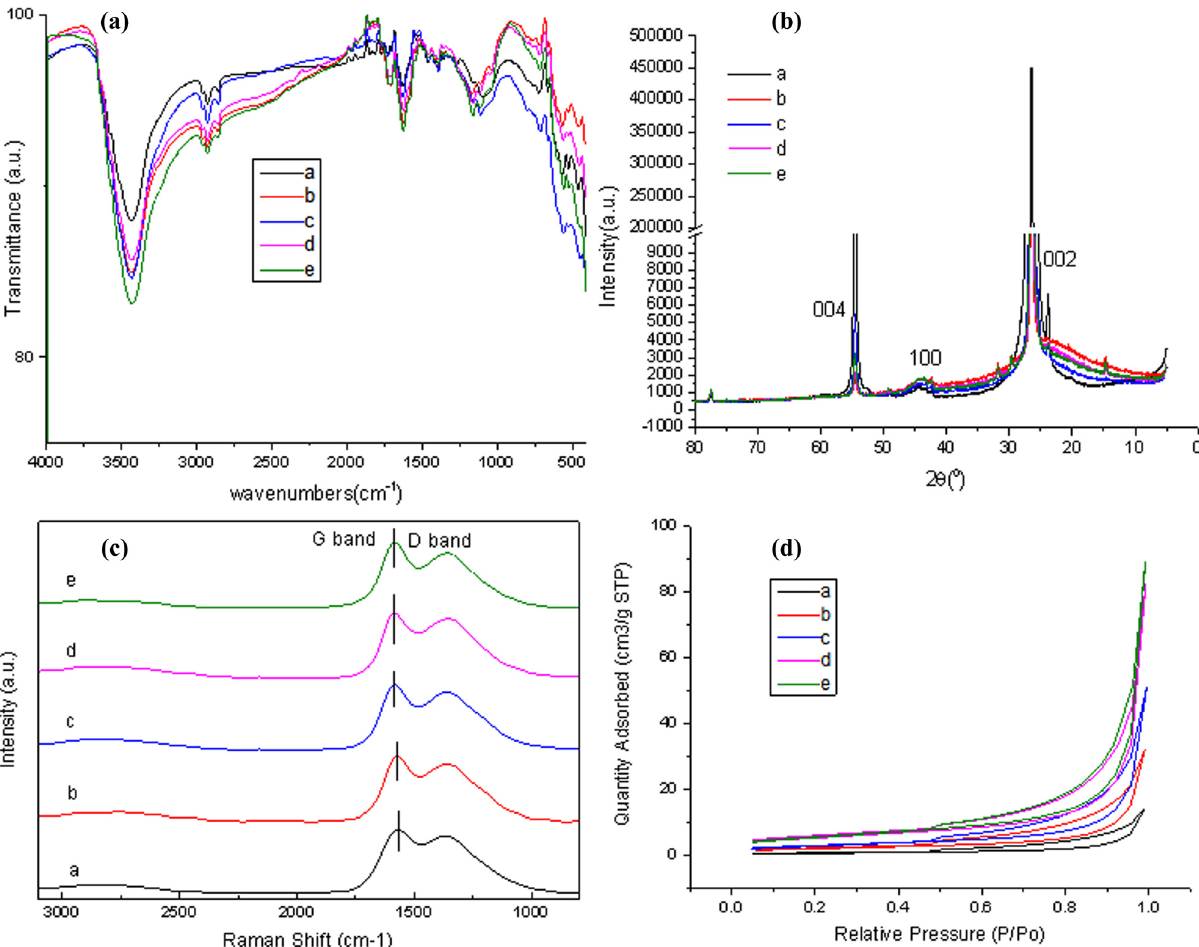
Figure 2: ( a ) FTIR spectra of the carbon solid acid catalysts prepared with di ff erent mass ratios of raw materials. ( b ) XRD results of the carbon solid acid catalysts prepared with di ff erent mass ratios of raw materials. ( c ) The Raman spectrum of the carbon solid acid catalysts prepared with di ff erent mass ratios of raw materials. ( d ) The BET curve of the carbon solid acid catalysts prepared with di ff erent mass ratios